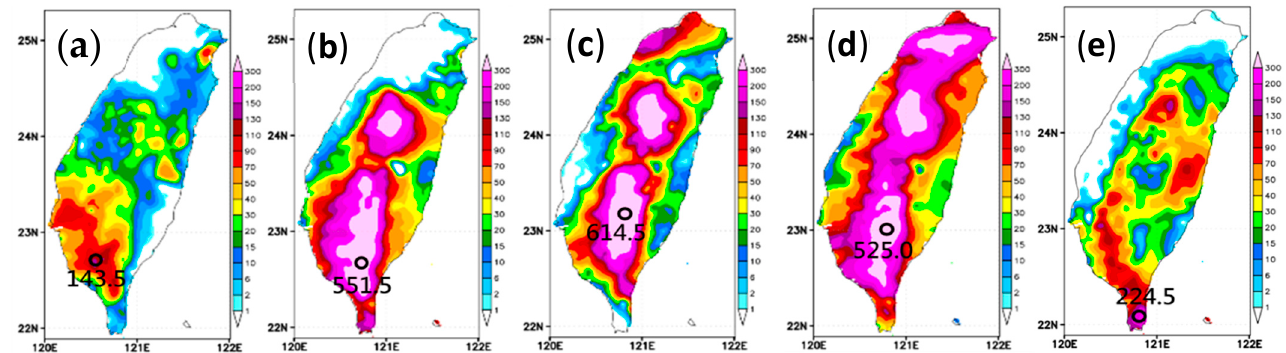
Figure 3. Daily rainfall distribution (mm; 0000-2400 UTC) from the gauge network in Taiwan on ( a ) 9, ( b ) 10, ( c ) 11, ( d ) 12, and ( e ) 13 June 2012. The location and value of daily maximum in each panel are marked.